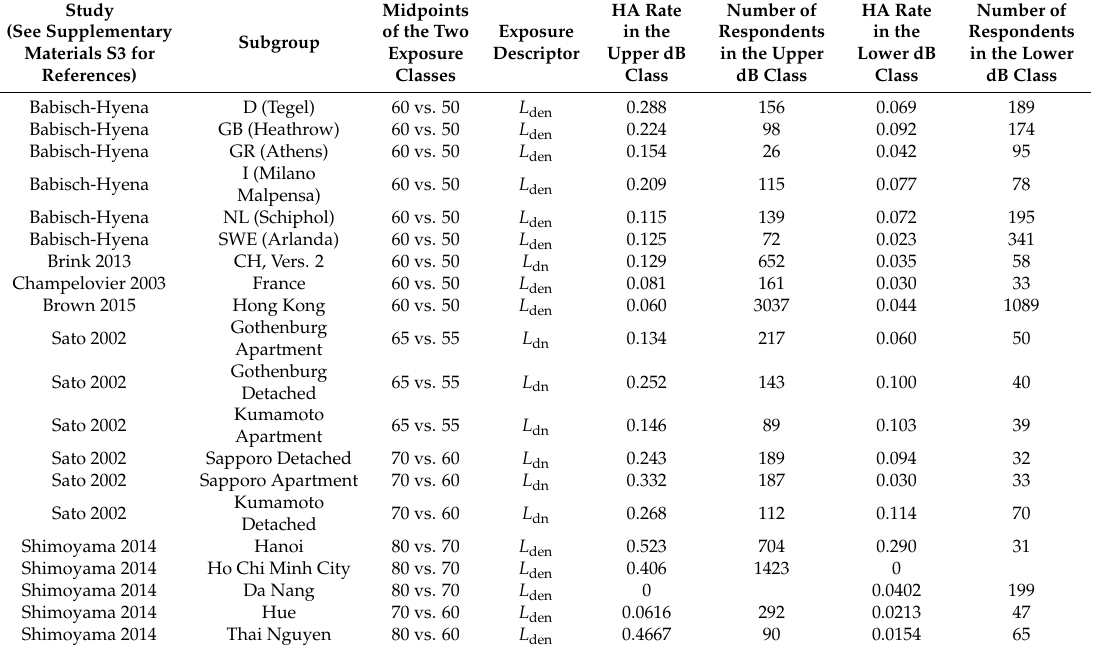
Table 4. Road traffic noise—HA rates and the number of respondents in two classes of exposure ( L den or L dn